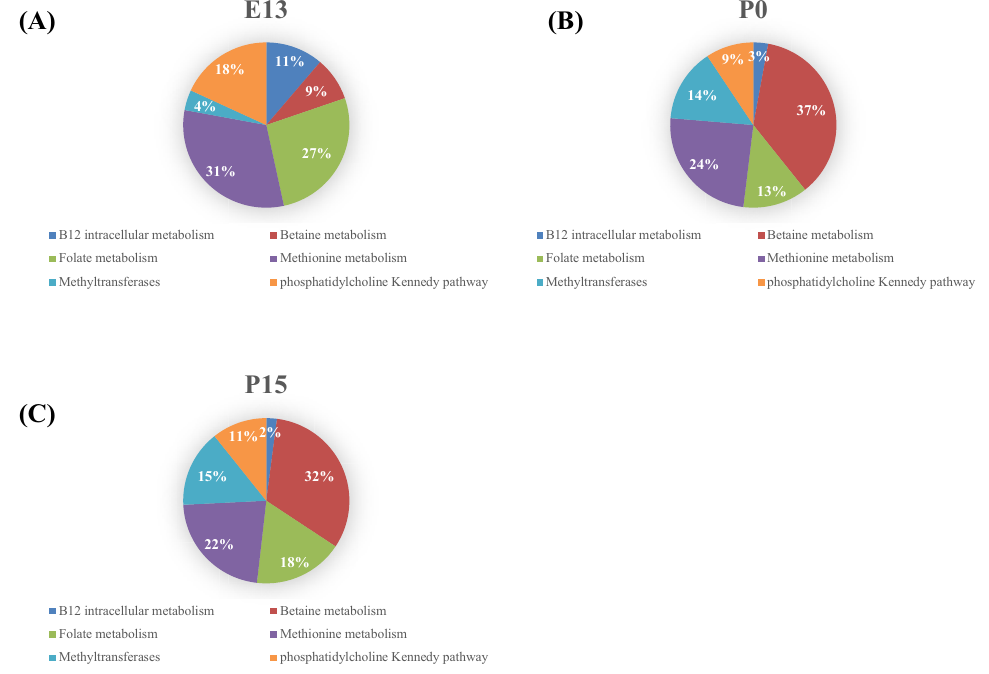
Figure 4. Percentages of liver mRNA expression of genes according to their metabolic pathway at a prenatal stage at embryonic day 13 ( A ), at birth ( B ) and at a postnatal stage, 15 days after birth ( C ).